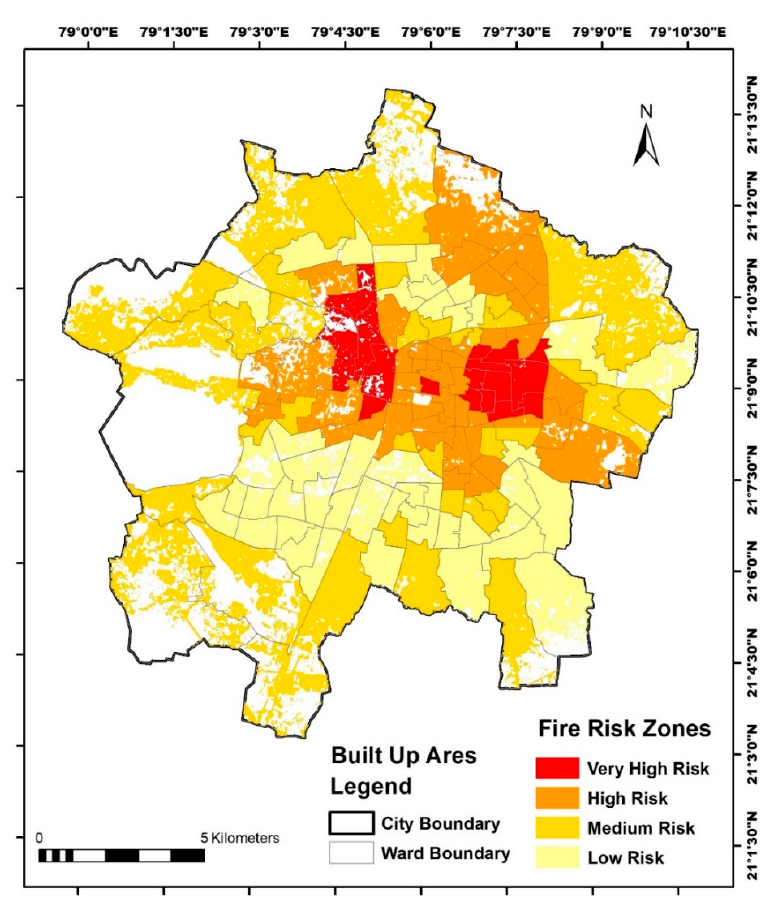
Figure 8. Built-up areas with structure fire risk zones . Table 4. Estimation of fire risk zones with significant